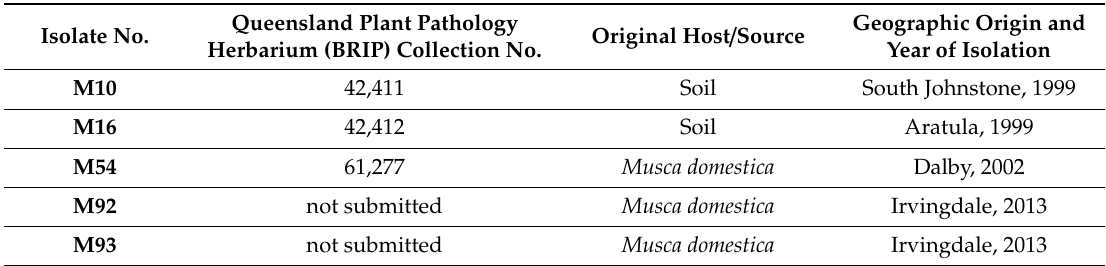
Table 1. Original source and geographic origin of Metarhizium anisopliae isolates collected in Queensland, Australia, and used in this